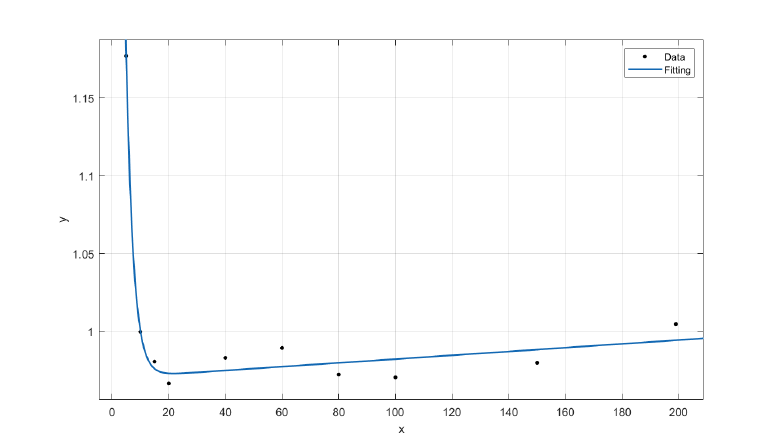
Figure 12. Fitted curve of the attenuation coefficient of the maximum induced voltage—Case A.